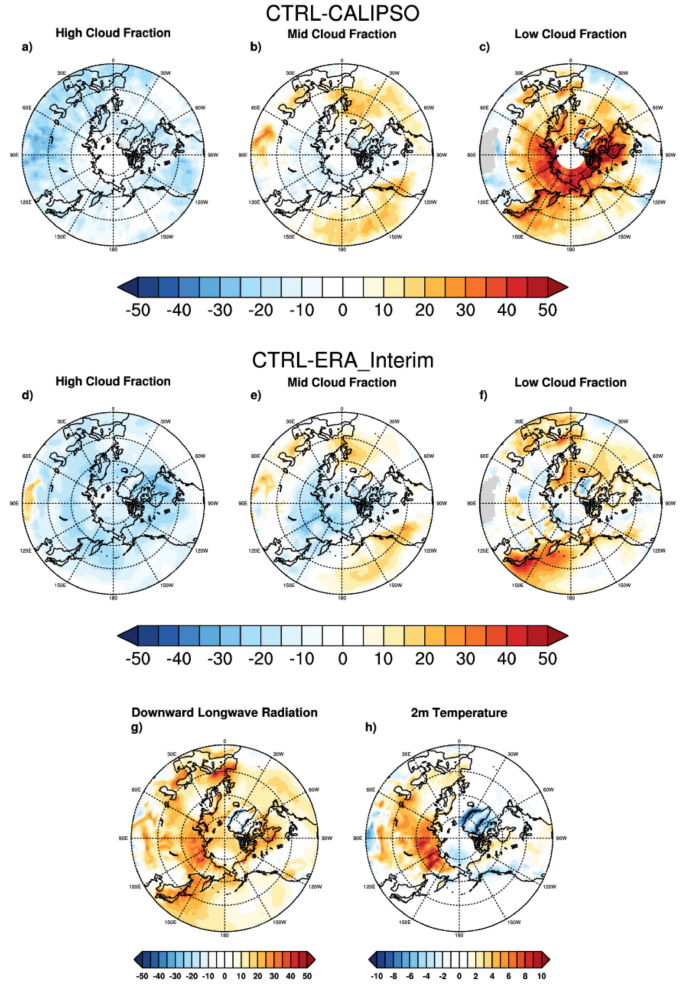
Figure 1. The bias of control simulation (CTRL) for the cloud fractions and the associated variables during DJF: ( a ) high, ( b ), mid, ( c ) low cloud fraction (%) against the CALIPSO-GOCCP observation, and ( d ) high, ( e ) mid, ( f ) low cloud fraction (%), ( g ) downward longwave radiation (W/m 2 ) and ( h ) 2 m air temperature against ERA-Interim